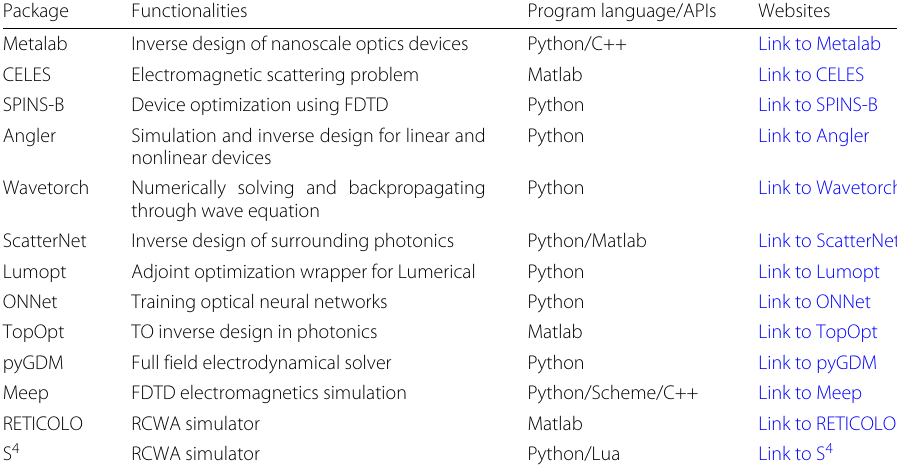
Table 2 Summary of open-source packages for inverse designs of meta-devices Package Functionalities Metalab Inverse design of nanoscale optics devices Electromagnetic scattering